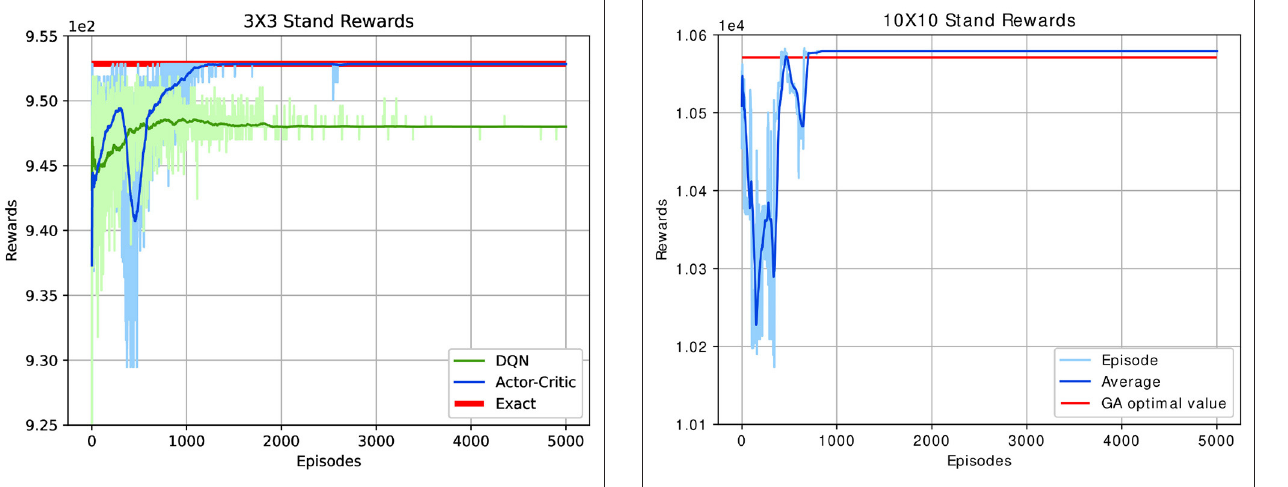
FIGURE 5 | Obtained DRL solutions compared to the optimal value for the 3 3 stands case. ×